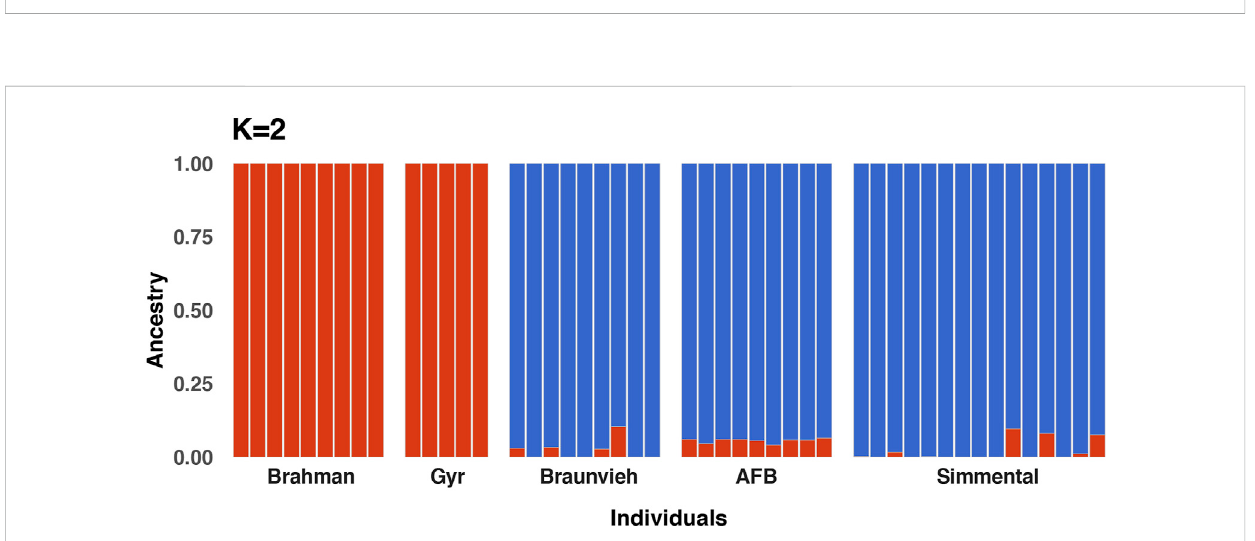
FIGURE 3 Population structure using 16,345 SNPs for fi ve cattle breeds consisting of 47 individuals. Admixture analysis showing the proportions of ancestral populations for K = 2, each vertical bar exempli fi es an